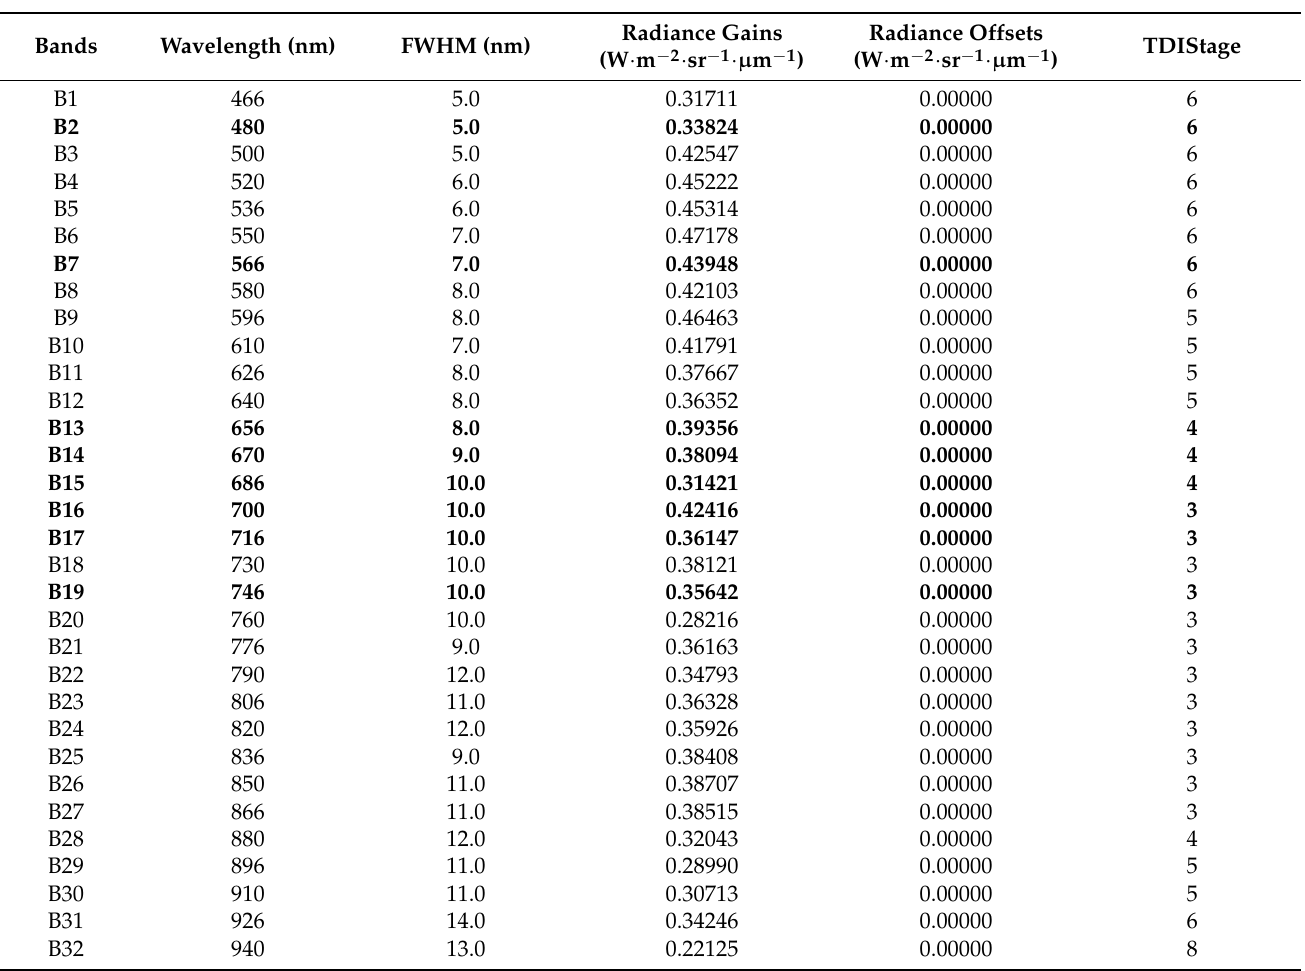
Table A1. OHS image bands setting and radiometric calibration coefficient. Wavelength represents the central wavelength of each band, FWHM (Full-Width Half-Maximum) is the wave width of each band, Radiance Gains and Radiance Offsets are the radiometric calibration gain coefficient and offset coefficient respectively, TDIStage is the integration series. The parts in bold are the bands used in this